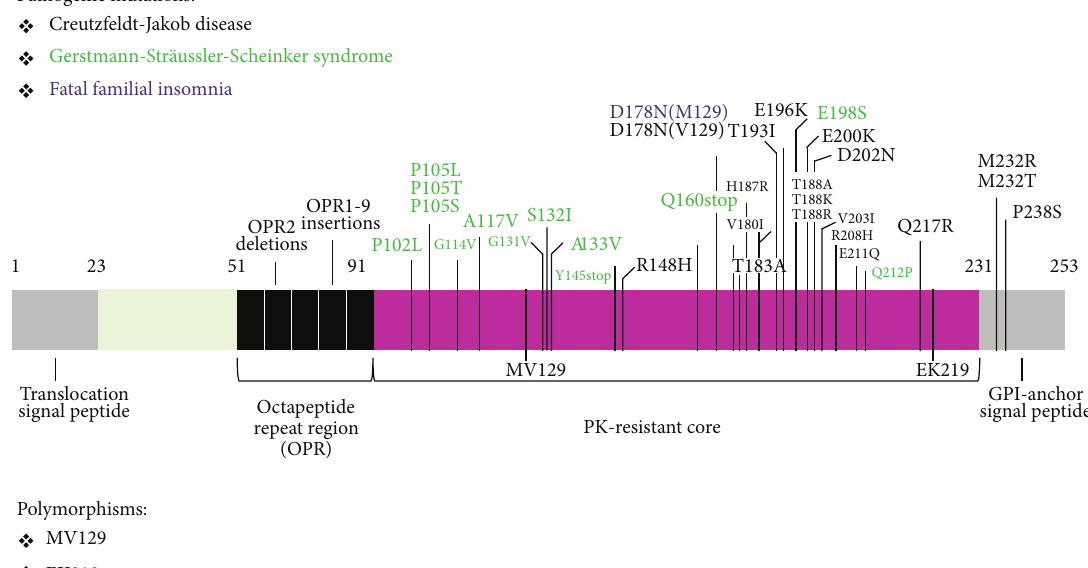
Figure 1: Pathogenic mutations and polymorphisms in the human PrP. The pathogenic mutations associated with human prion diseases are shown above the human PrP coding sequence. These consist of 1, 2, or 4–9 octapeptide repeat insertions (OPR1-9) within the octapeptide repeat region between codons 51 and 91, a 2 octapeptide repeat deletion (OPR2), and various point mutations causing missense or stop amino- acid substitutions. Point mutations are designated by the wild-type amino acid preceding the codon number, followed by the mutant residue, using single letter amino-acid nomenclature. Polymorphic variants are shown below the PrP coding sequence.